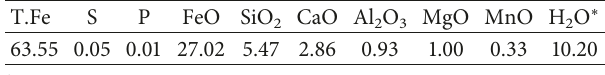
Table 1: Chemical composition of the concentrate (mass%).